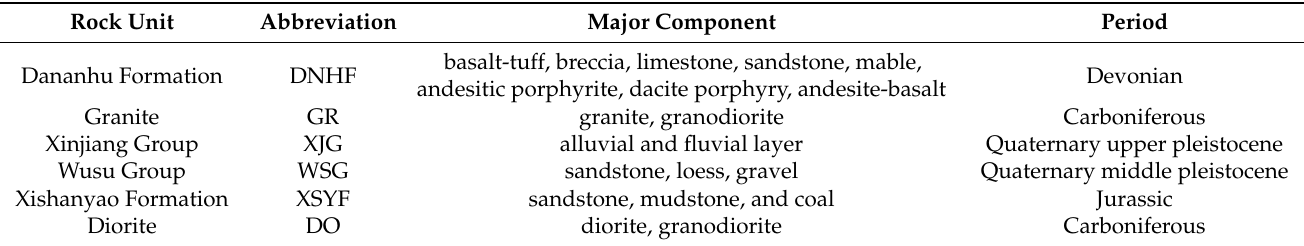
Table 1. Detailed information of the rock units in the study area.